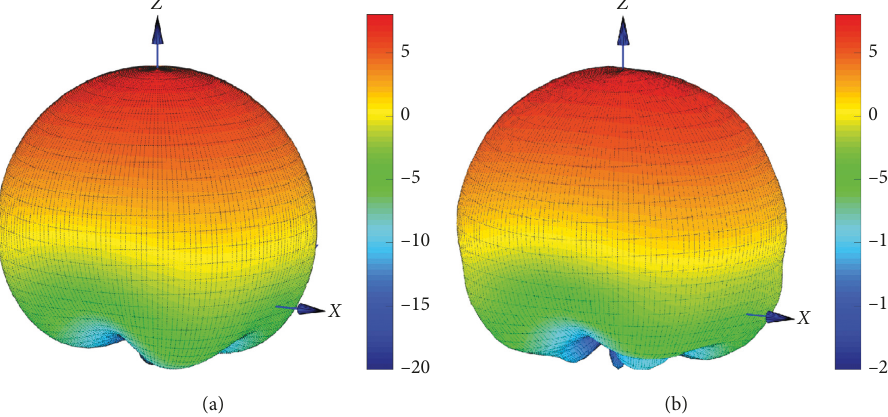
Figure 12: Theoretical and experimental 3D radiation patterns comparison for a central frequency at 1.25GHz. (a) Simulation. (b)